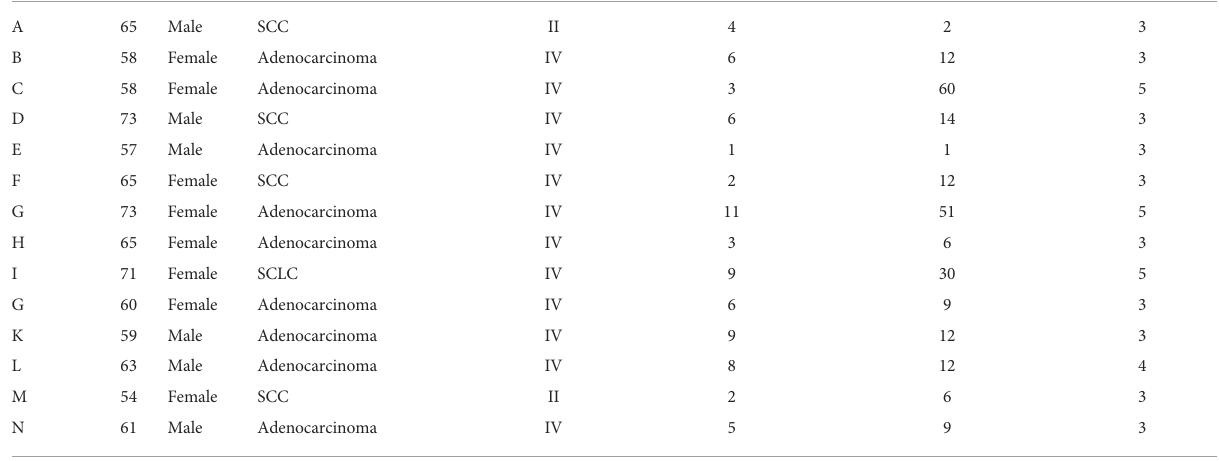
TABLE 9 Characteristics of participants (N =